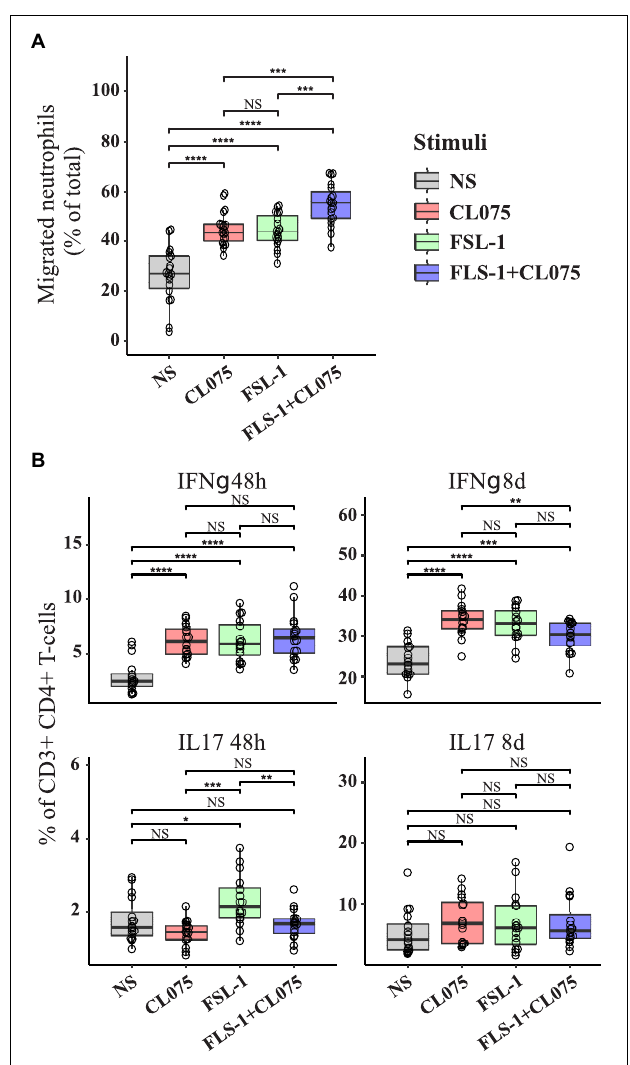
FIGURE 5 | Functional effects on immune activation in vitro of differential cytokine regulation. (A) Human neutrophils were isolated from the blood of healthy donors ( n = 3), loaded with CellTracker Deep Red and placed on a polycarbonate filter above a well containing supernatants from stimulated human monocytes ( n = 8) or RPMI. Neutrophil migration was measured after 60 min incubation. While TLR8 and TLR2 stimulation alone increased migration in a similar manner, co-stimulation was significantly increased compared to either stimuli alone as predicted. (B) Human primary CD4 + T cells were differentiated with supernatants from non-stimulated and stimulated monocytes ( n = 8). IL17-positive T cells, indicative of a Th17 phenotype was increased by TLR2 stimuli after 48 h, while IFN γ -positive T cells, indicative of a Th1 phenotype was reduced by co-stimulation after 8 days. ∗ p <